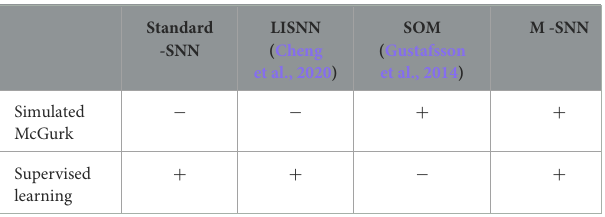
TABLE 1 Performance of different algorithms on simulating McGurk effect (“+” indicates that such a correspondence exists, while “ − ” indicates not).